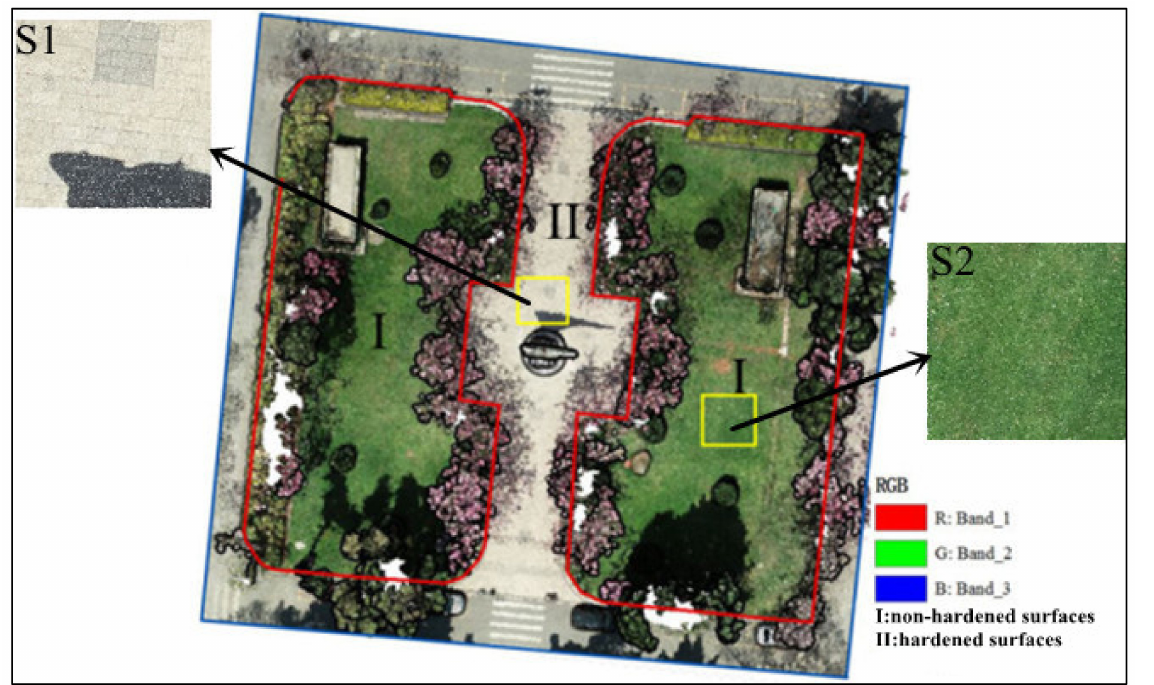
Figure 4. Geomorphology classification and sampling surface selection.